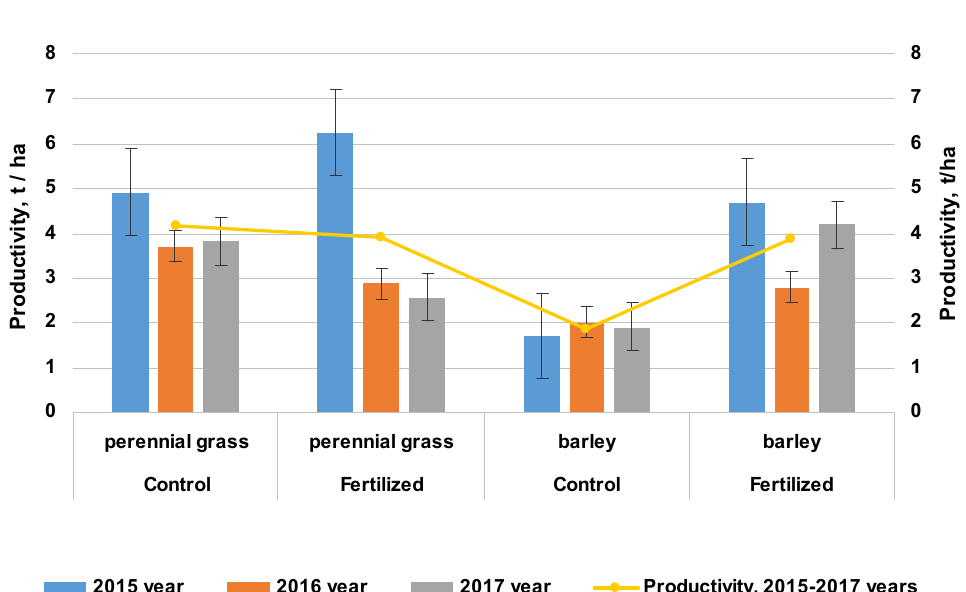
Figure 1. Productivity of crops depending on the use of mineral fertilizers, t/ha (2015–2017 years). On average for 2015–2017 optimization of soil moisture and conditions of mineral nutrition of plants contributed to an increase in barley yield by more than 100%, up to 3.88 t/ha. The collection of dry matter of perennial grasses during the study period in the fertilized version was at the control level due to a decrease in the share of the legume component with long-term use of nitrogen